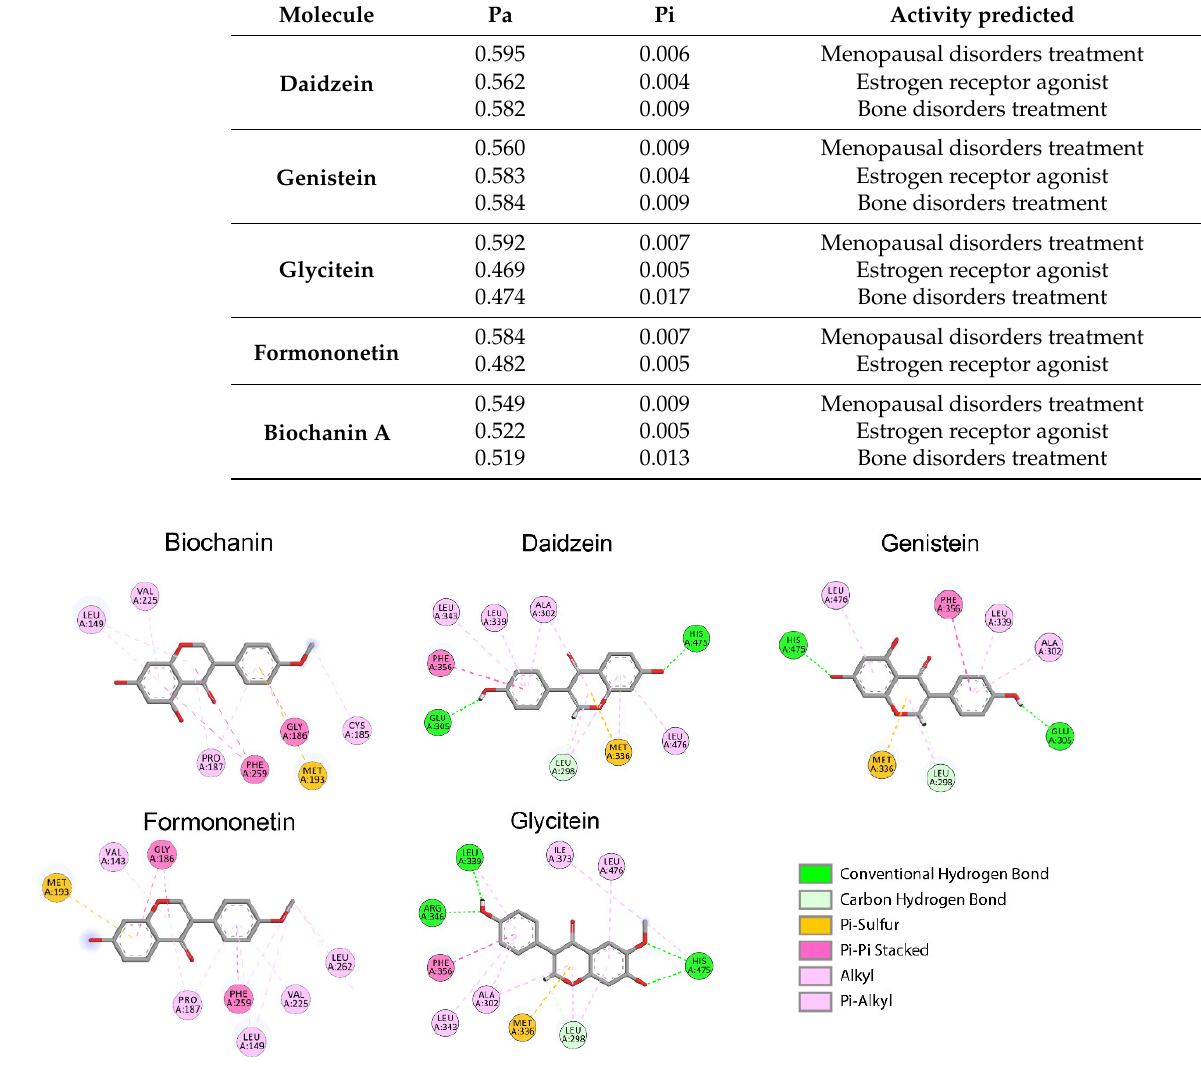
Figure 4. Docking poses predicted with estrogen receptor (PDB ID 1QKM).